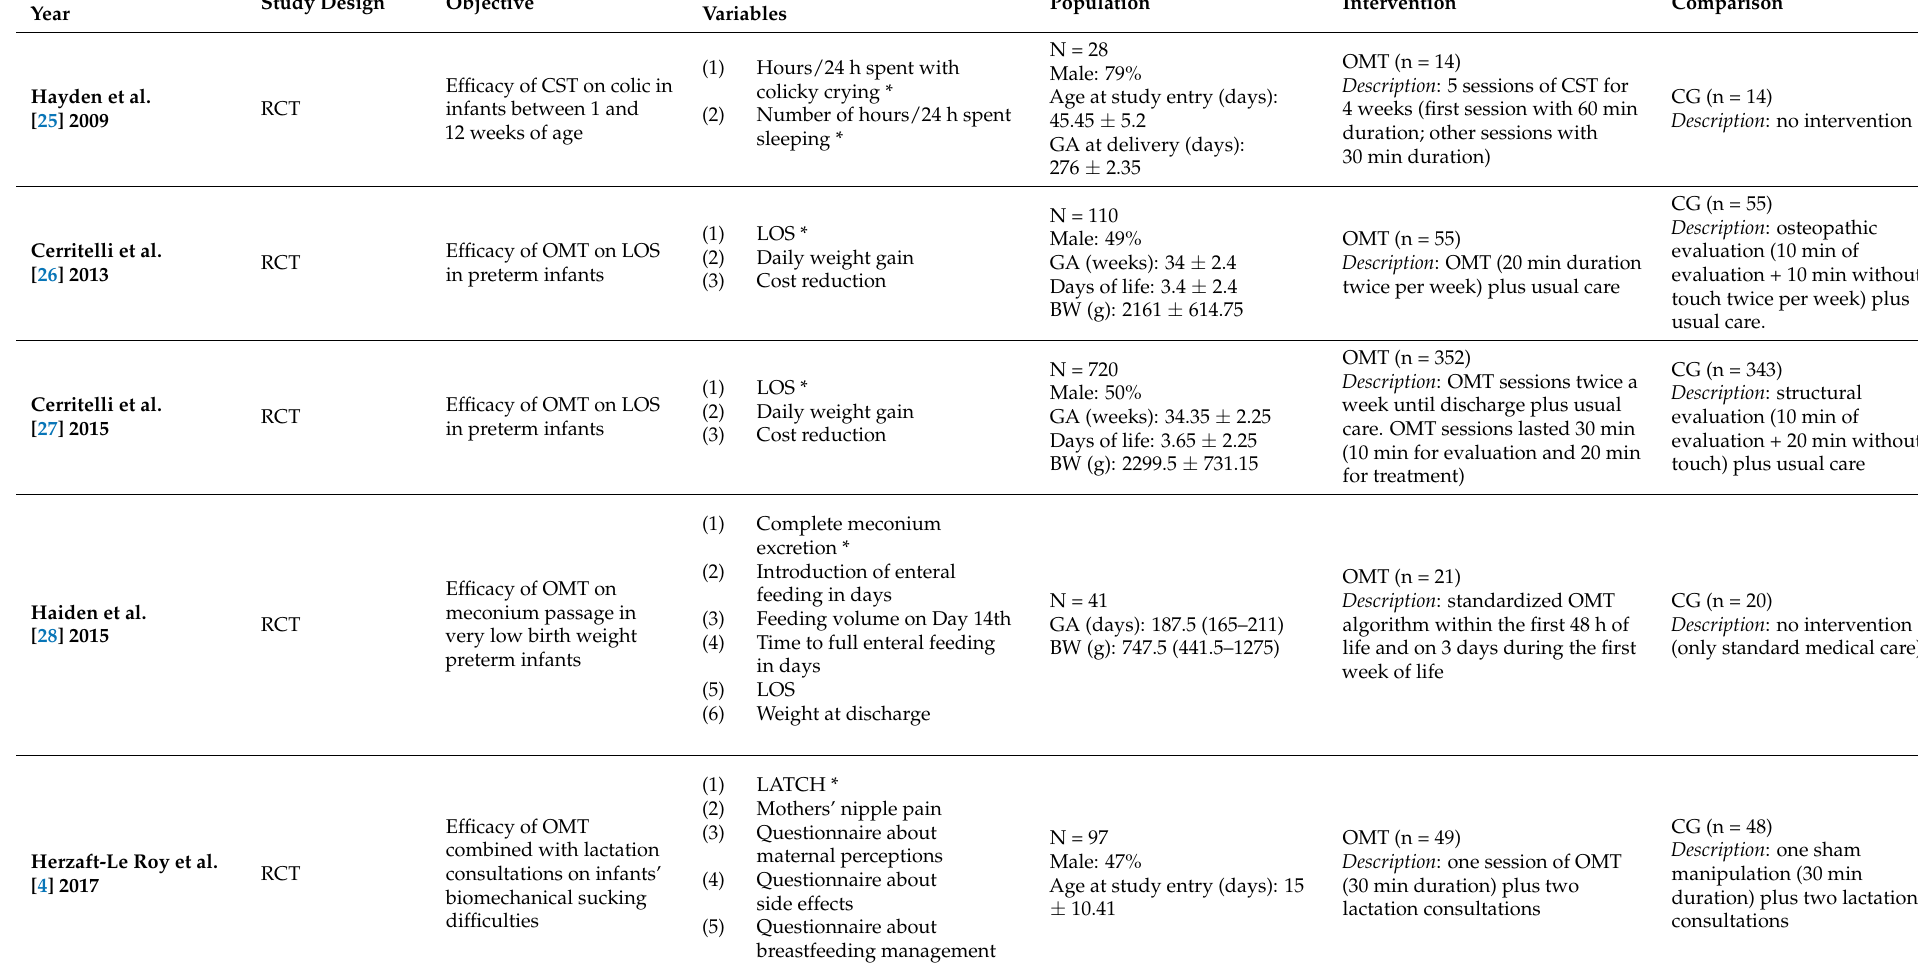
Table 1. Overview of included